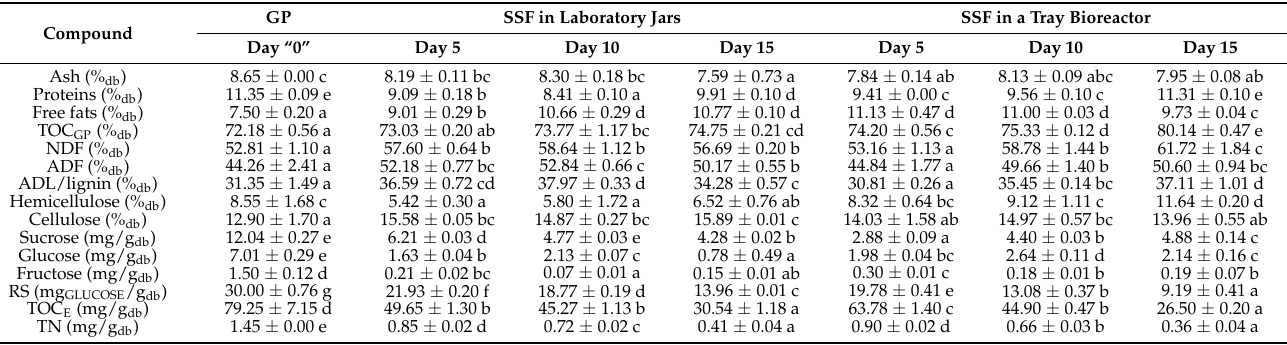
Table 2. Chemical composition of GP before (day “0”) and after SSF (day 5, 10, 15) by R. oryzae in laboratory jars and tray